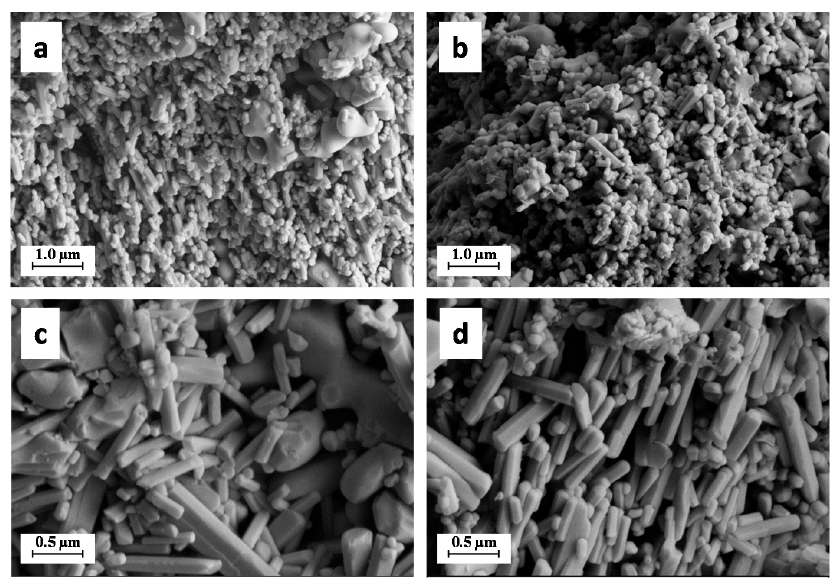
Figure 4. SEM pictures of CaP ( a , c ) and CaP–HS ( b , d ) at 50,000× magnification on the top ( a , b ) and 100,000× magnification on the bottom ( c , d ).